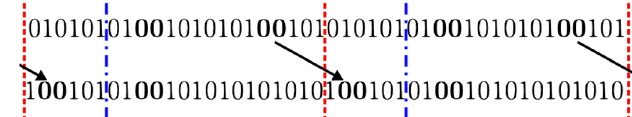
FIG. 3. Top: A possible arrangement of two domain walls is shown in a ‘‘repeated zone scheme’’ with the domain-wall positions marked by the bold 00 strings. The red dotted line marks the boundaries of the 0 frame and the blue dot-dashed line marks a shifted frame, the 6 frame. Bottom: The second domain wall moves to a new position. When viewed from the 0 frame, this domain wall moves across the frame boundary where it becomes the first domain wall in a different topological sector. Viewed from the 6 frame, the domain wall does not move across the boundary and the topological sector does not change.